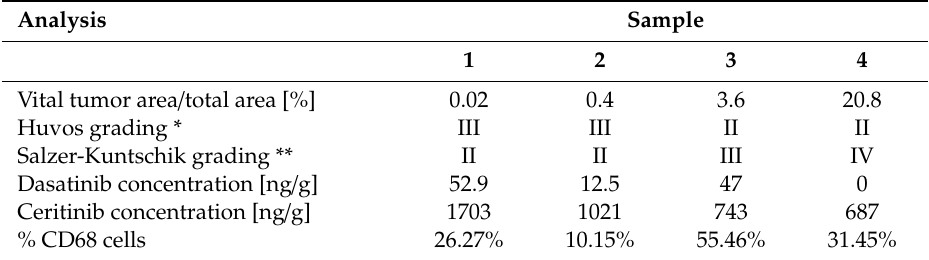
Table 2. Correlation of tumor regression and drug penetration in four different pleural specimens. Analysis